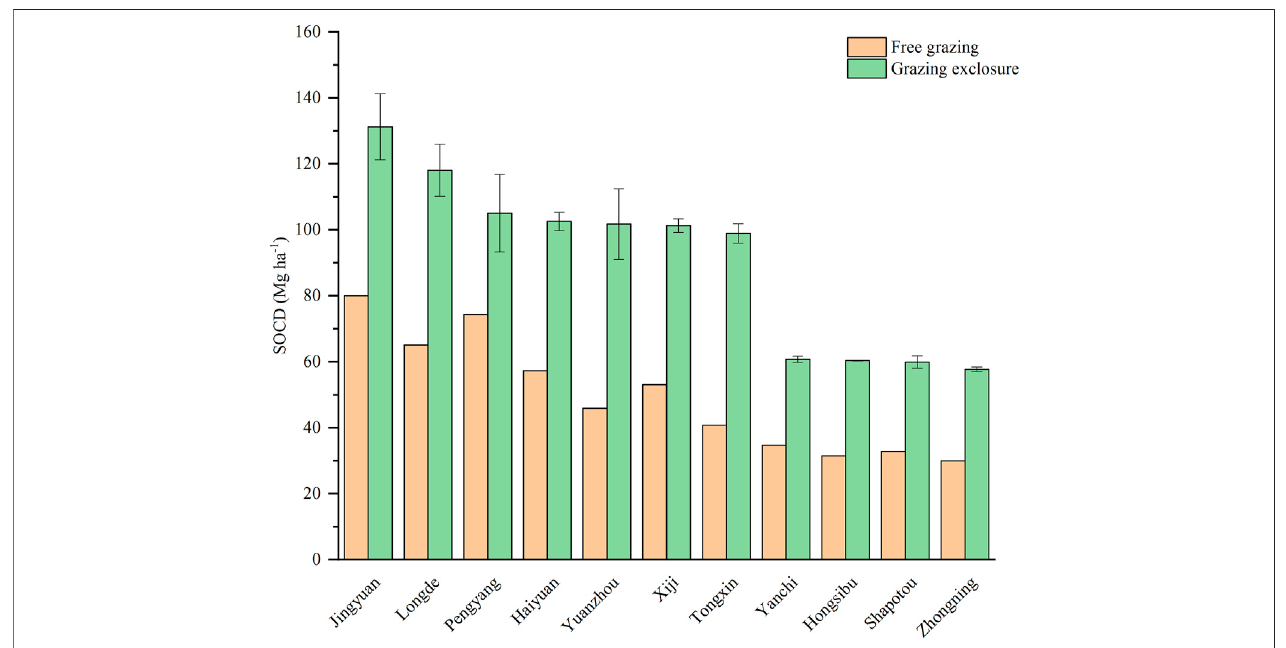
FIGURE 2 | Grassland SOCD with free grazing (before the GGP) and grazing exclosure (after the GGP).